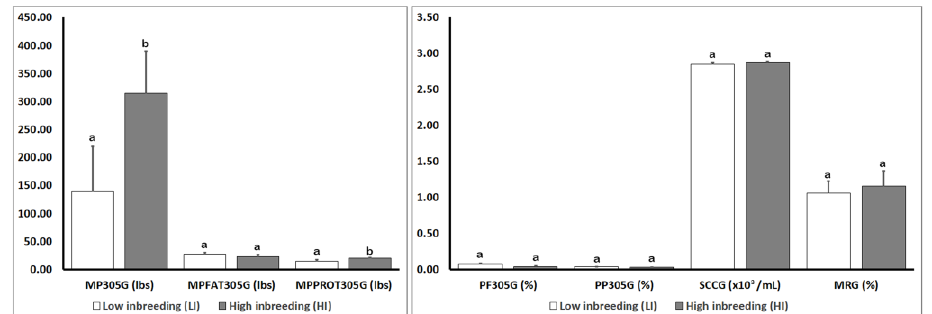
Figure 2. Effect of the degree of inbreeding (LI versus HI) on the genomic parameters for production traits in high-producing primiparous dairy cows. Production genomic values: MP305G: Milk Production at 305 days; MPFAT305G: Fat Production at 305 days; MPPROT305G: Protein Production at 305 days; PF305G: Percent of Fat at 305 days; PP305G: Percent of Protein at 305 days; SCCG: Somatic Cell Count; MRG: Mastitis Resistance. Different letters show statistical differences between values ( p ≤ 0.05). lbs: Pounds; %: Percentage; SEM: Standard Error of the Mean.